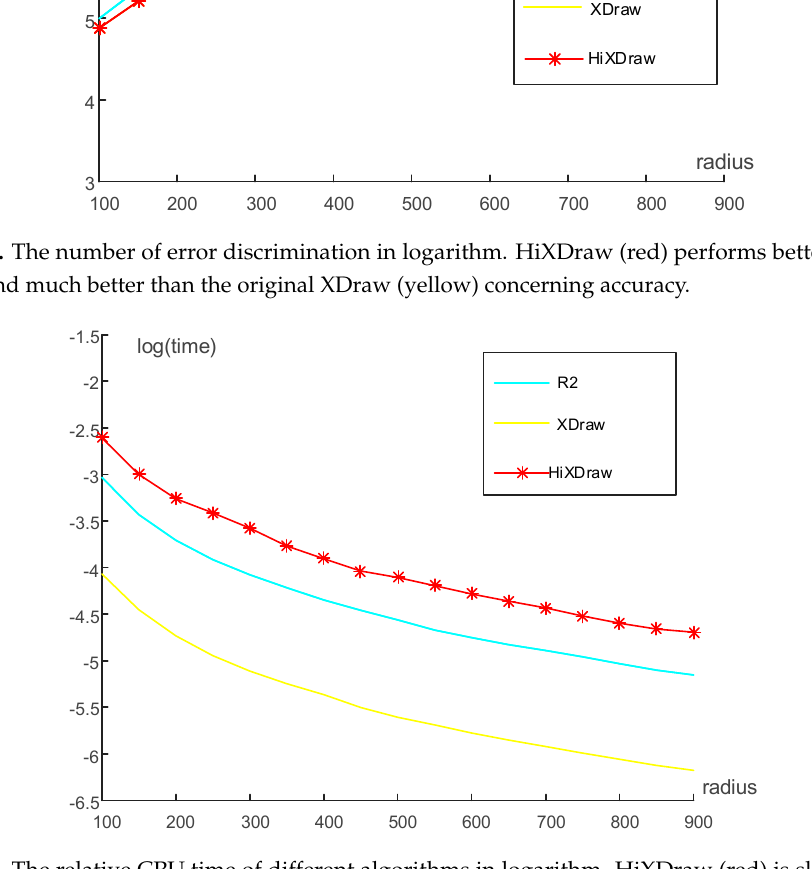
Figure 7. The relative CPU time of different algorithms in logarithm. HiXDraw (red) is slower than XDraw (yellow) and R2 (cyan).